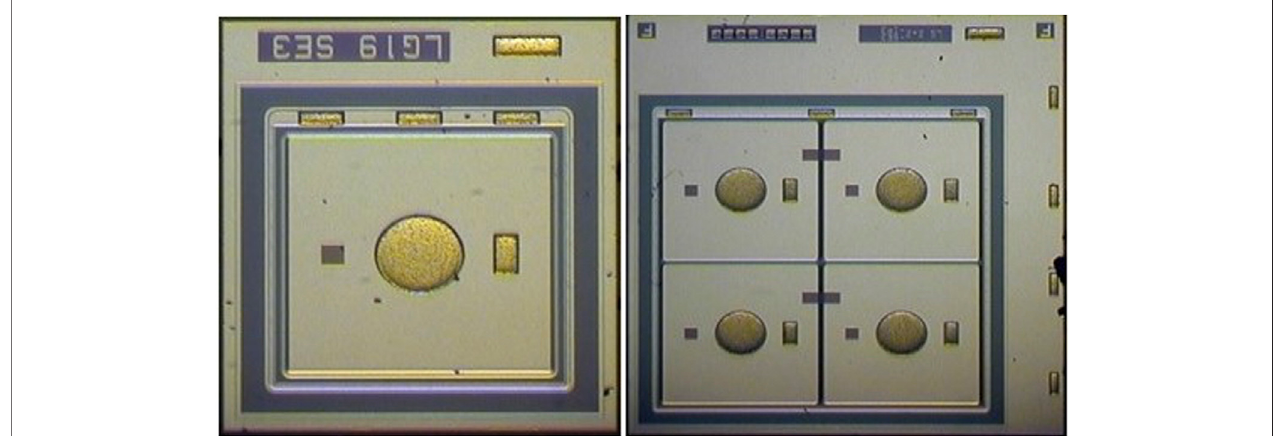
FIGURE 1 | Photographs of (left) a prototype LGAD and (right) a quad sensor prototype.